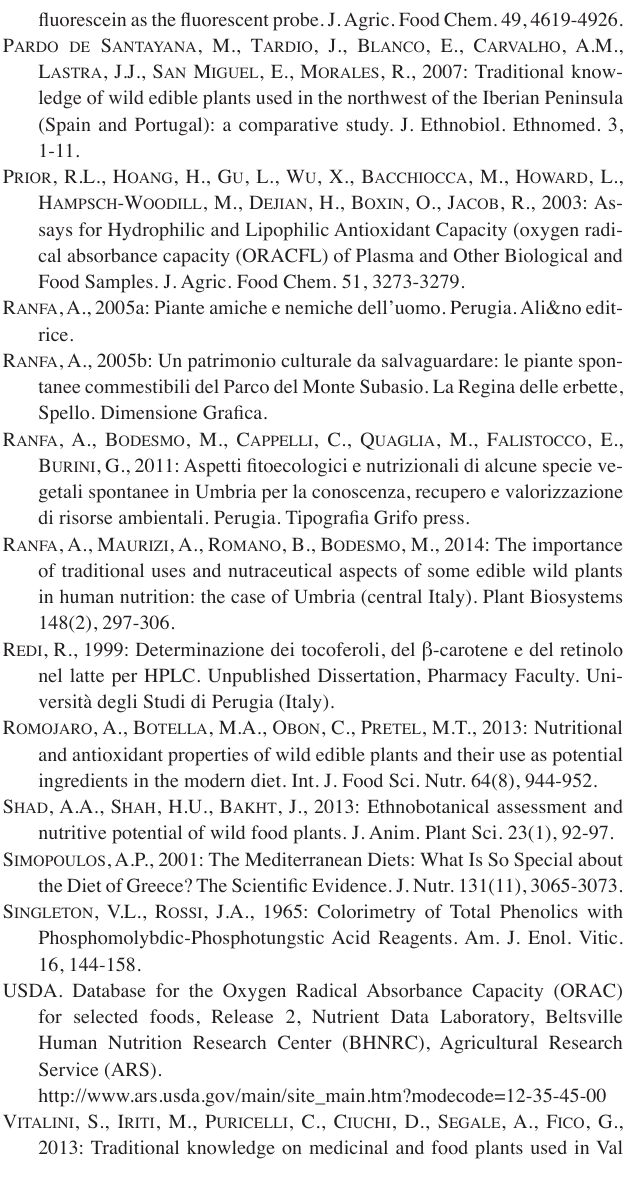
a source: Tabelle di composizione degli alimenti. INRAN Istituto Nazionale di Ricerca per gli Alimenti e la Nutrizione. b source: Banca Dati di Composizione degli Alimenti per Studi Epidemiologici in Italia (BDA) – IEO Istituto Europeo di